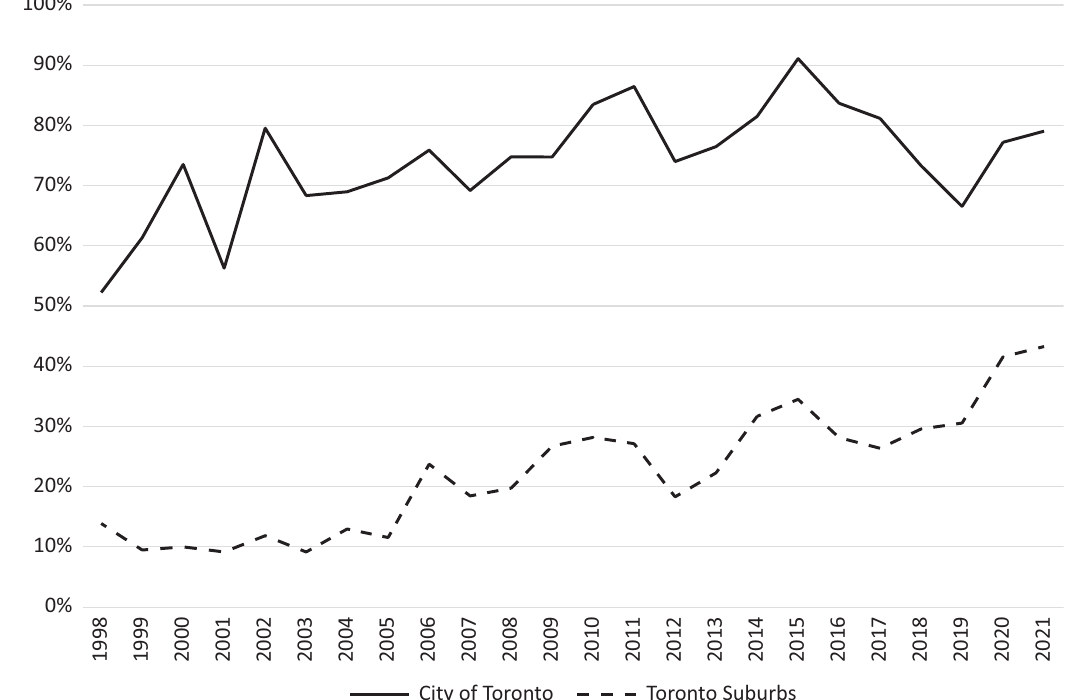
Figure 3. Annual proportion of new build housing completions that are condominiums in the Toronto CMA, 1998–2021. Source: Calculated by the authors using data from CMHC